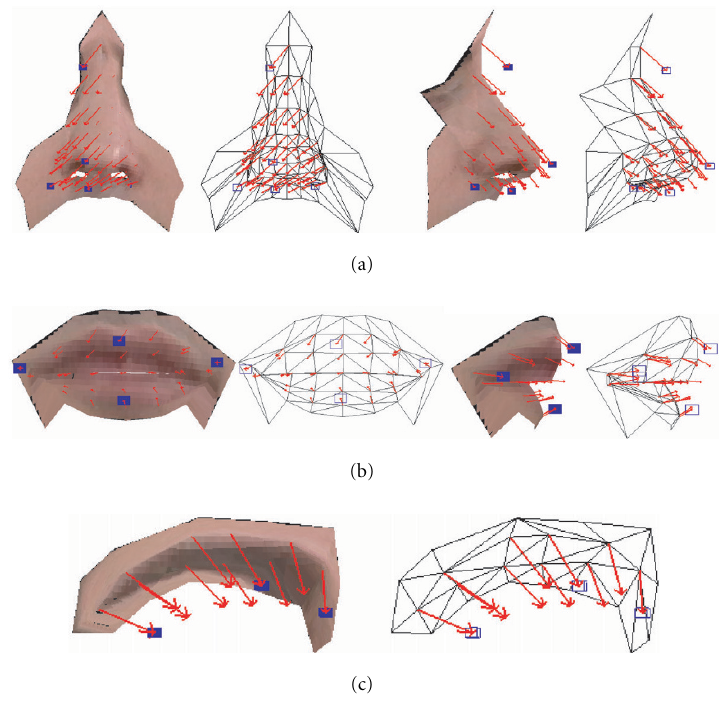
Figure 3: Local adaptation of the nose (a), mouth (b), and right eyebrow (c). The wireframe (both textured and transparent) is drawn at the rigidly deformed position, while the arrows represent the nonrigid deformation and the cubes show the desired position of the feature